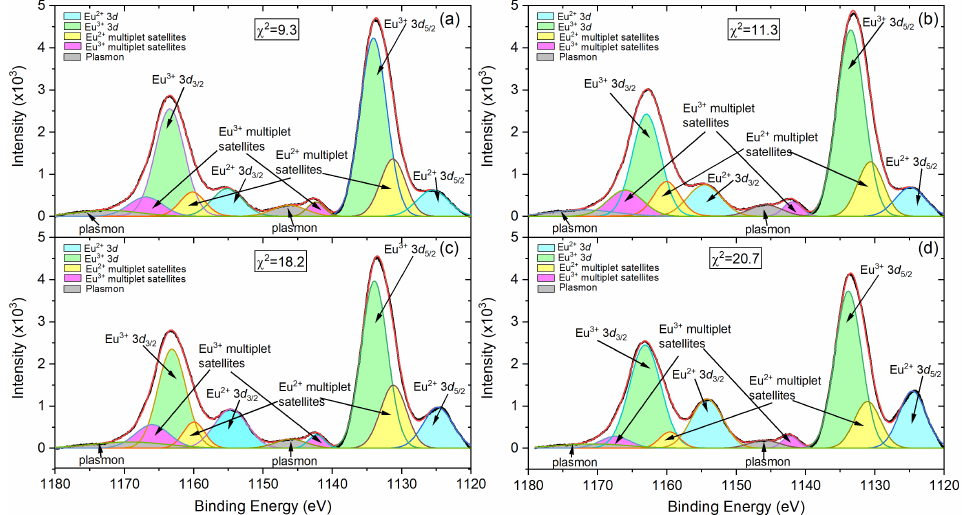
Figure 6. The deconvoluted 3 d XPS spectra of the Eu 3 O 4 film on Si/SiO 2 substrate using Al K α source (1486.68 eV) after the Shirley background subtraction, measured at etching time ( a ) t = 210 s, ( b ) t = 360 s, ( c ) t = 450 s and ( d ) t = 510 s. The raw data (black line), fitting curve (red line), Eu 2 + 3 d (blue shaded peaks), Eu 2 + multiplet satellites (yellow shaded peaks), Eu 3 + 3 d (green shaded peaks), Eu 3 + multiplet satellites (magenta shaded peaks) and plasmon excitations (grey shaded